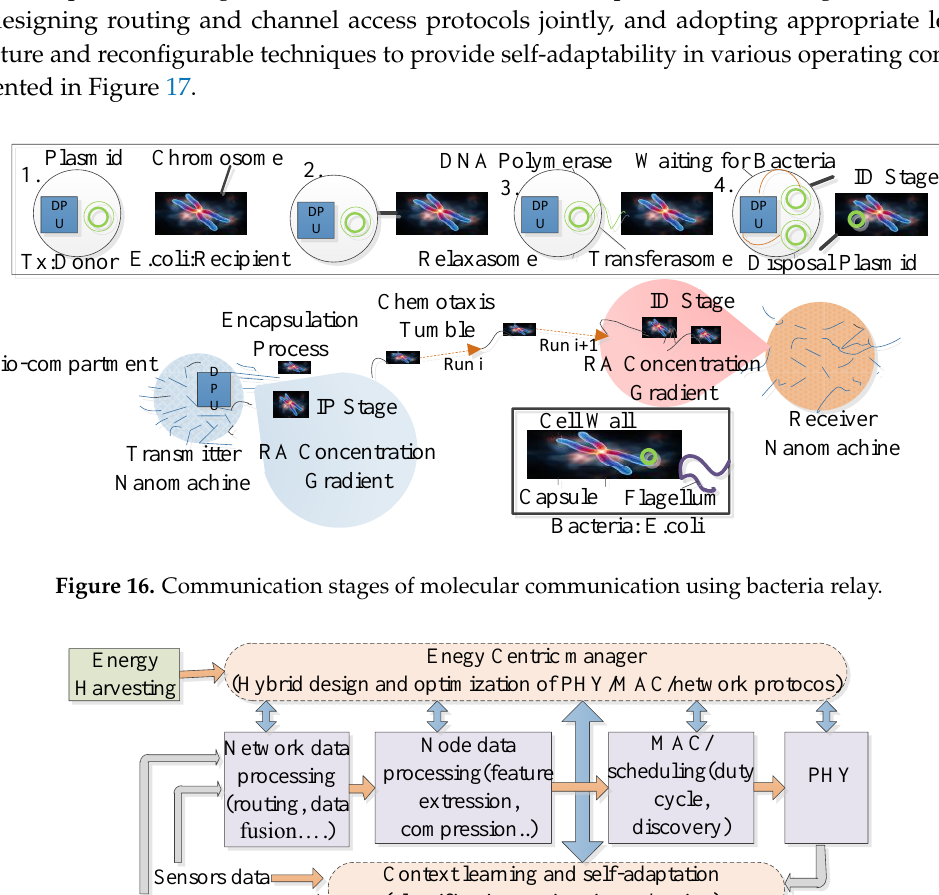
Figure 17. Energy and context centric framework.